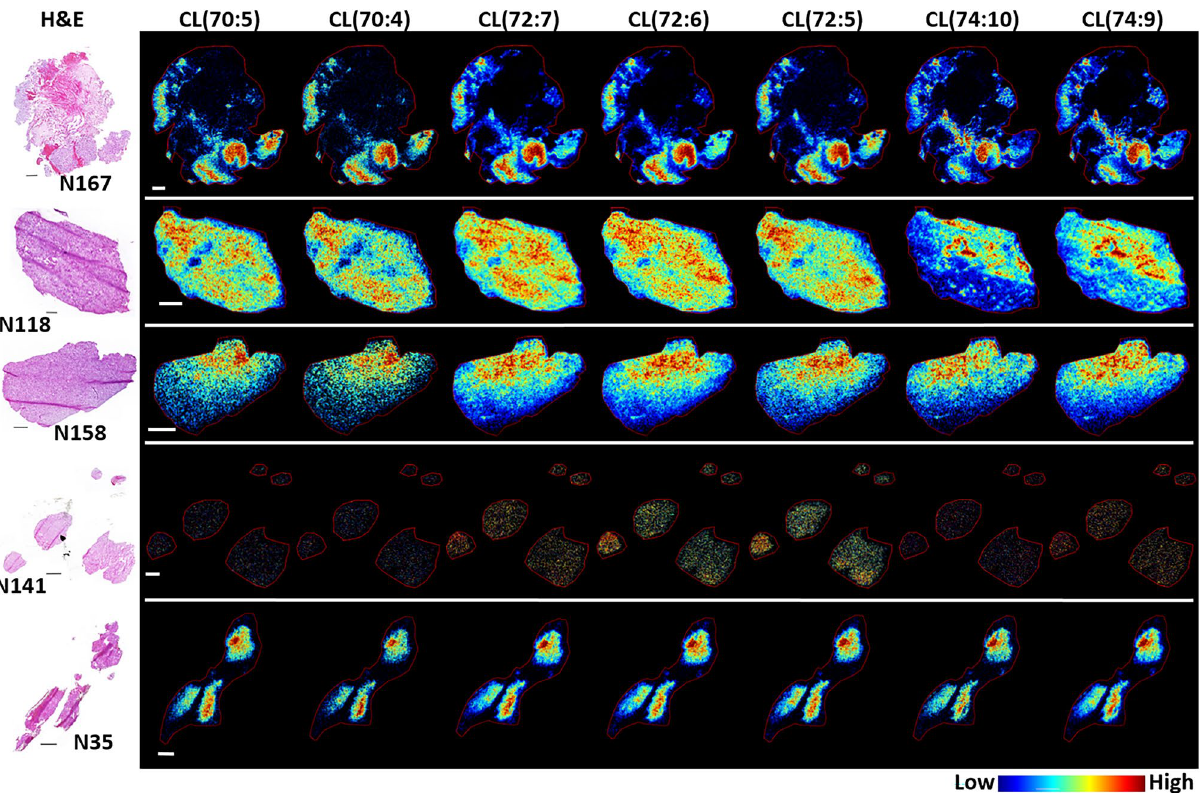
Figure 2. Representative MS images of several cardiolipin (CL) species. CL(70:5), (70:4), (72:7), (72:6), (72:5), (74:10) and (74:9) correspond to m/z 1425.984, 1427.997, 1449.978, 1451.995, 1454.011, 1471.966 and 1473.981, respectively. Images were acquired at 30 µm pixel resolution from 5 µm thick sections; the H&E stained section of each sample is shown in the left panel. Scale bars are 1